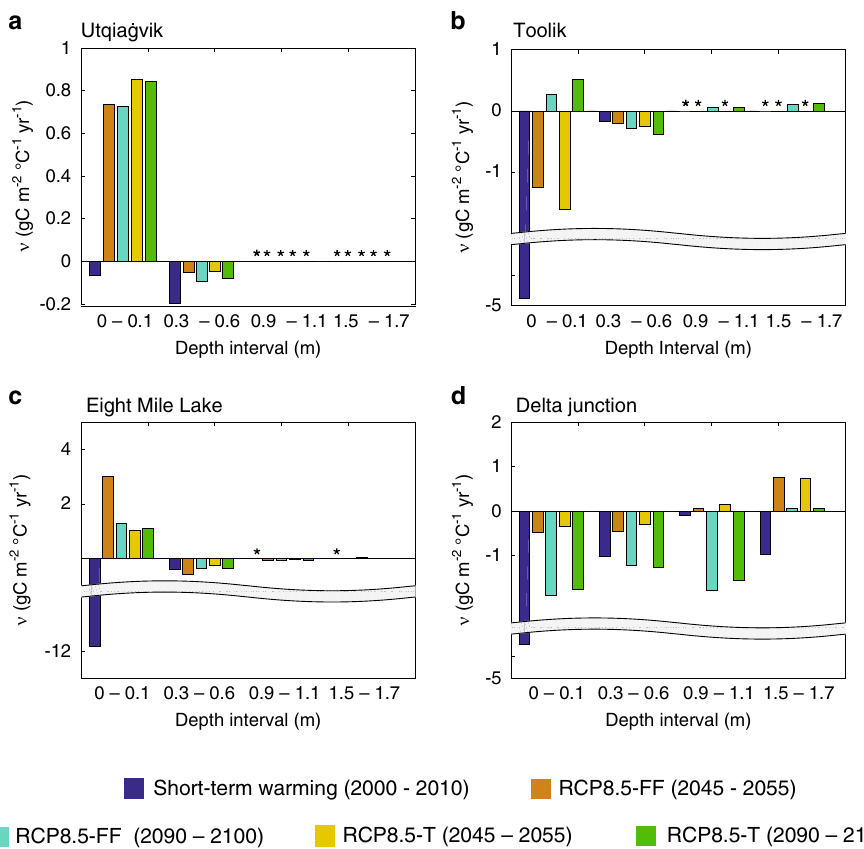
Fig. 3 The magnitude and sign of the emergent temperature sensitivities varies between sites, short-term and long-term warming, and depth. The fi gure shows the modeled depth-resolved emergent temperature sensitivity ( ν ) of soil organic carbon at each a Utqia ġ vik, b Toolik, c Eight Mile Lake, and d Delta Junction, under short-term and the two long-term (i.e., RCP8.5-T and RCP8.5-FF) scenarios across two time periods (2045 – 2055 and 2090 – 2100). A positive ν value denotes a period where the ecosystem is acting as a sink for carbon, while a negative value indicates the ecosystem is losing carbon. Asterisk denotes periods where permafrost was simulated to occur at that depth, and therefore no change in soil organic carbon stock occurred.